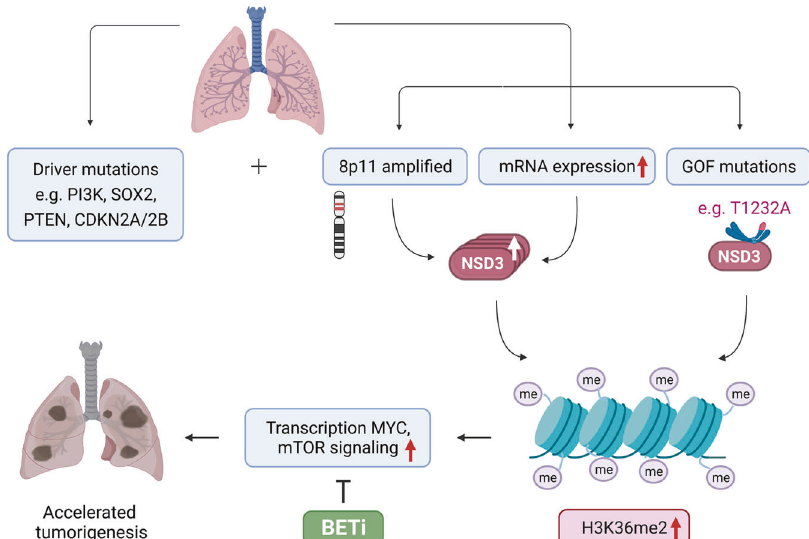
Fig. 1 Model of the role for enhanced NSD3 activity in tumorigenesis of LUSC. LUSC tumorigenesis is driven by numerous genetic alternations such as 8p11-12 ampli fi cation, constitutively active PI3K, overexpression of SOX2, and deletion of CDKN2A/2B and PTEN. Yuan et al. identi fi ed NSD3 ampli fi cation as the causative mutation of the 8p11-12 amplicon in LUSC. Ampli fi caton of NSD3 resulted in elevated NSD3 expression and hence increased dimethylation of H3K36, which cooperates with other driver mutations to boost LUSC pathogenesis. The GOF mutant NSD3 (T1232A) can act like ampli fi ed or overexpressed NSD3 in elevating H3K36me2 expression. Overexpression or GOF mutation of NSD3 increases H3K36me2 synthesis, which stimulates transcription of crucial oncogenic targets including genes involved in